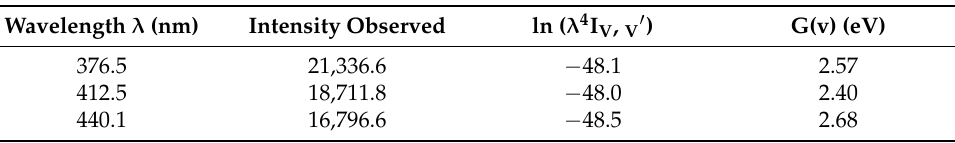
Table 3. The intensity of the electronic bands of the CaO molecule to calculate the vibrational temperature (plasma